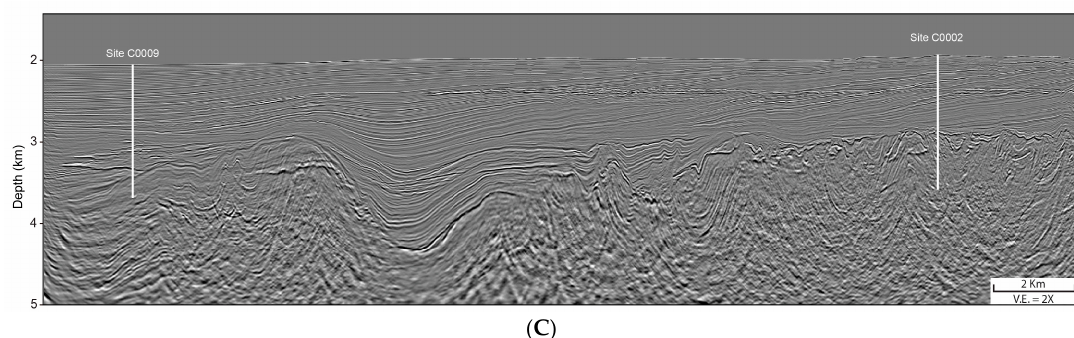
Figure 1. ( A ) The Nankai Trough is formed by the oblique subduction of the Philippine Sea Plate beneath the Eurasian Plate at a rate of about 4.0–6.5 cm/year [24]. Sediments are delivered to the basin by submarine channels (red arrows) and are being incorporated into the underlying thickening accretionary prism [25,26]. Our study site perimeter is bounded by the red box and drill sites C0002, C0009 are indicated by red dots. The blue dot marks the location of the Atsumi Knoll drill site; ( B ) Kumano Basin bathymetry. The survey perimeter is indicated by the dashed black line; ( C ) Arbitrary seismic line through Sites C0002 and C0009 for sediment and drilling depth reference.